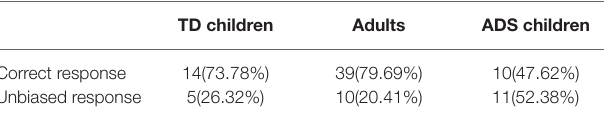
TABLE 1 | Correct vs. unbiased pattern of responses in relation to age (left) and in relation to Development type